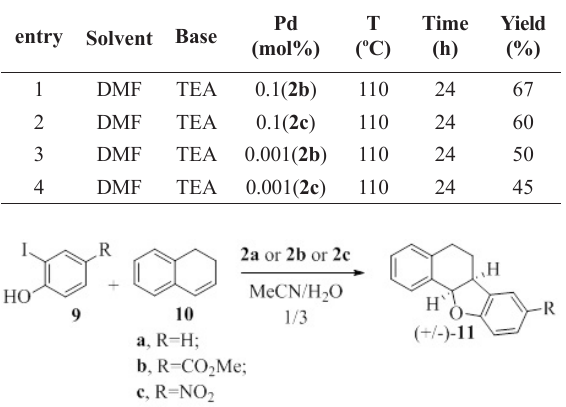
Figure 6 - Oxyarylation reaction of 10 with 9 in the presence of palladacycles 2a - c .